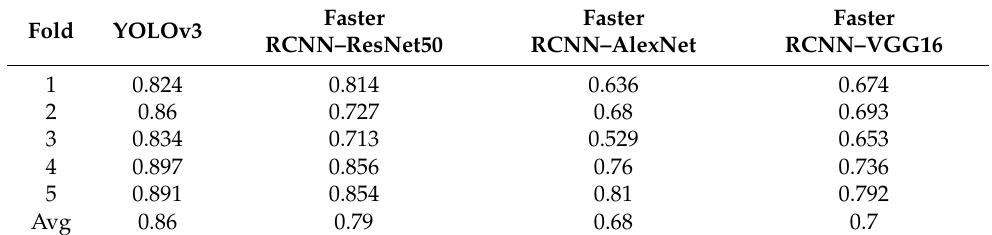
Table 2. Classification accuracies.